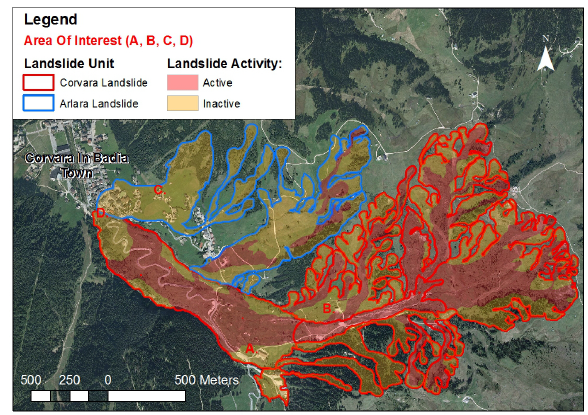
Figure 1. Map of the investigated